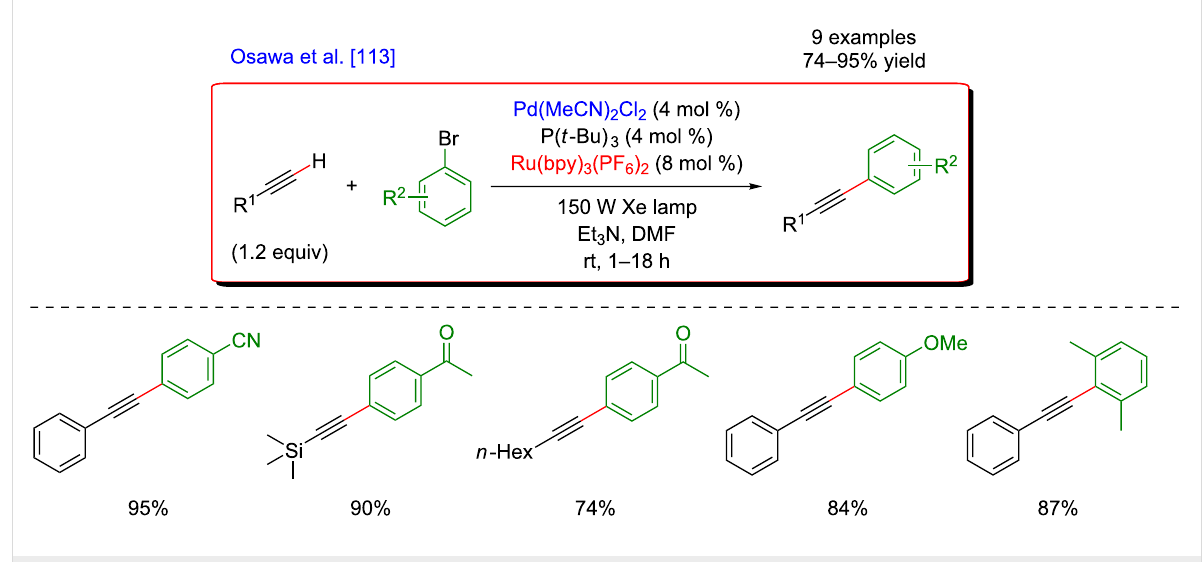
Figure 51: First example of a dual palladium/photoredox catalysis for Sonogashira-type couplings.